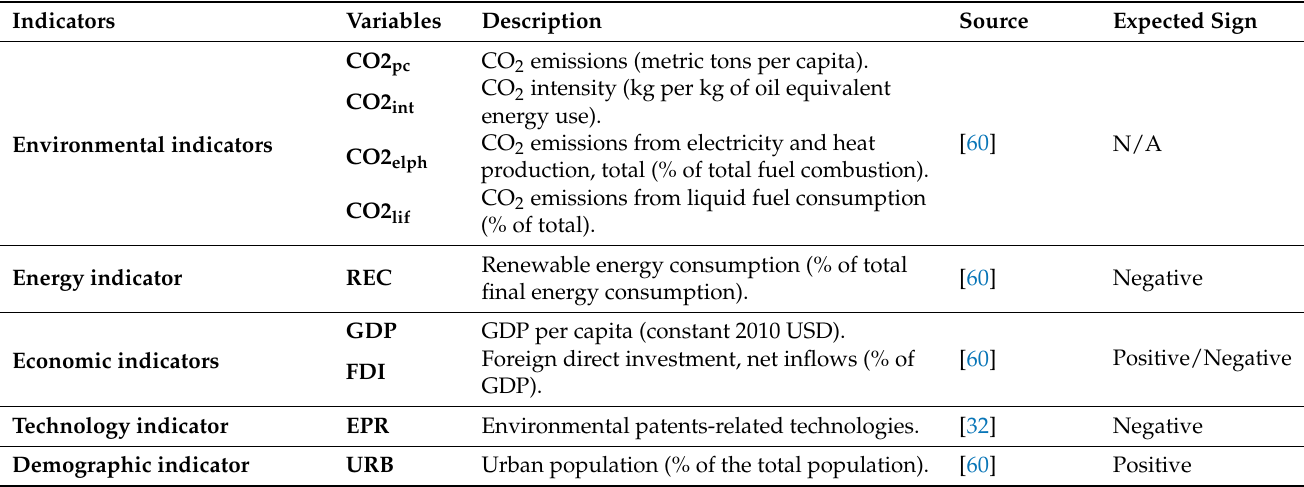
Table 1. Description of variables and expected